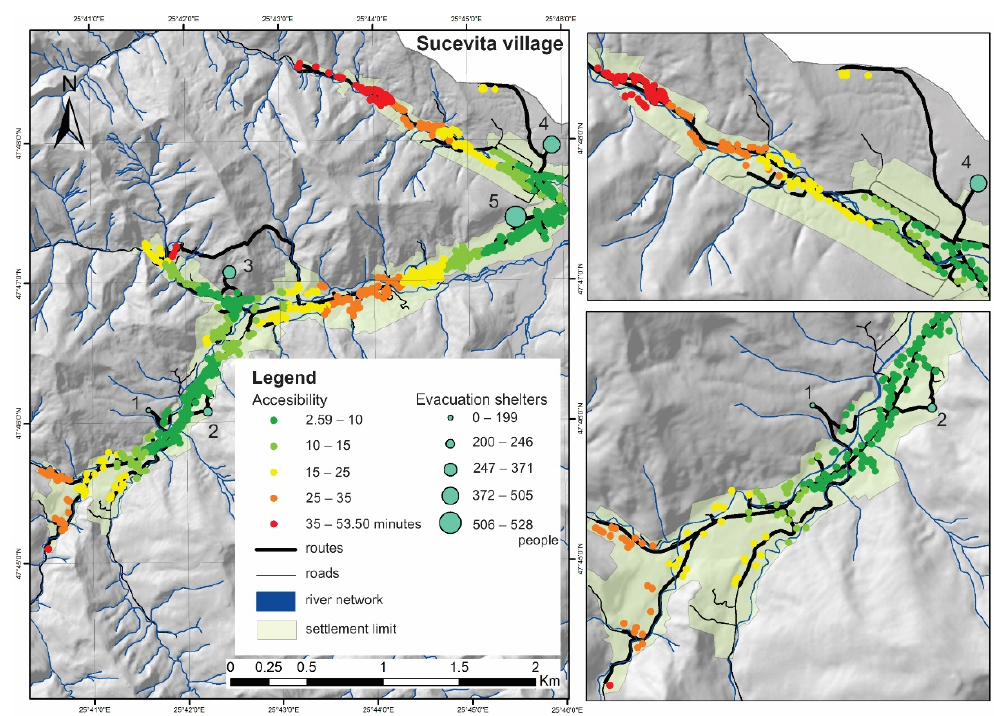
Figure 9. Optimal evacuation routes and accessibility of the population for Sucevi ț a village. Table 2. Summary table on the time required to travel distances to evacuation areas for Sucevi ț a village. Time to Travel the Distance (Minutes)